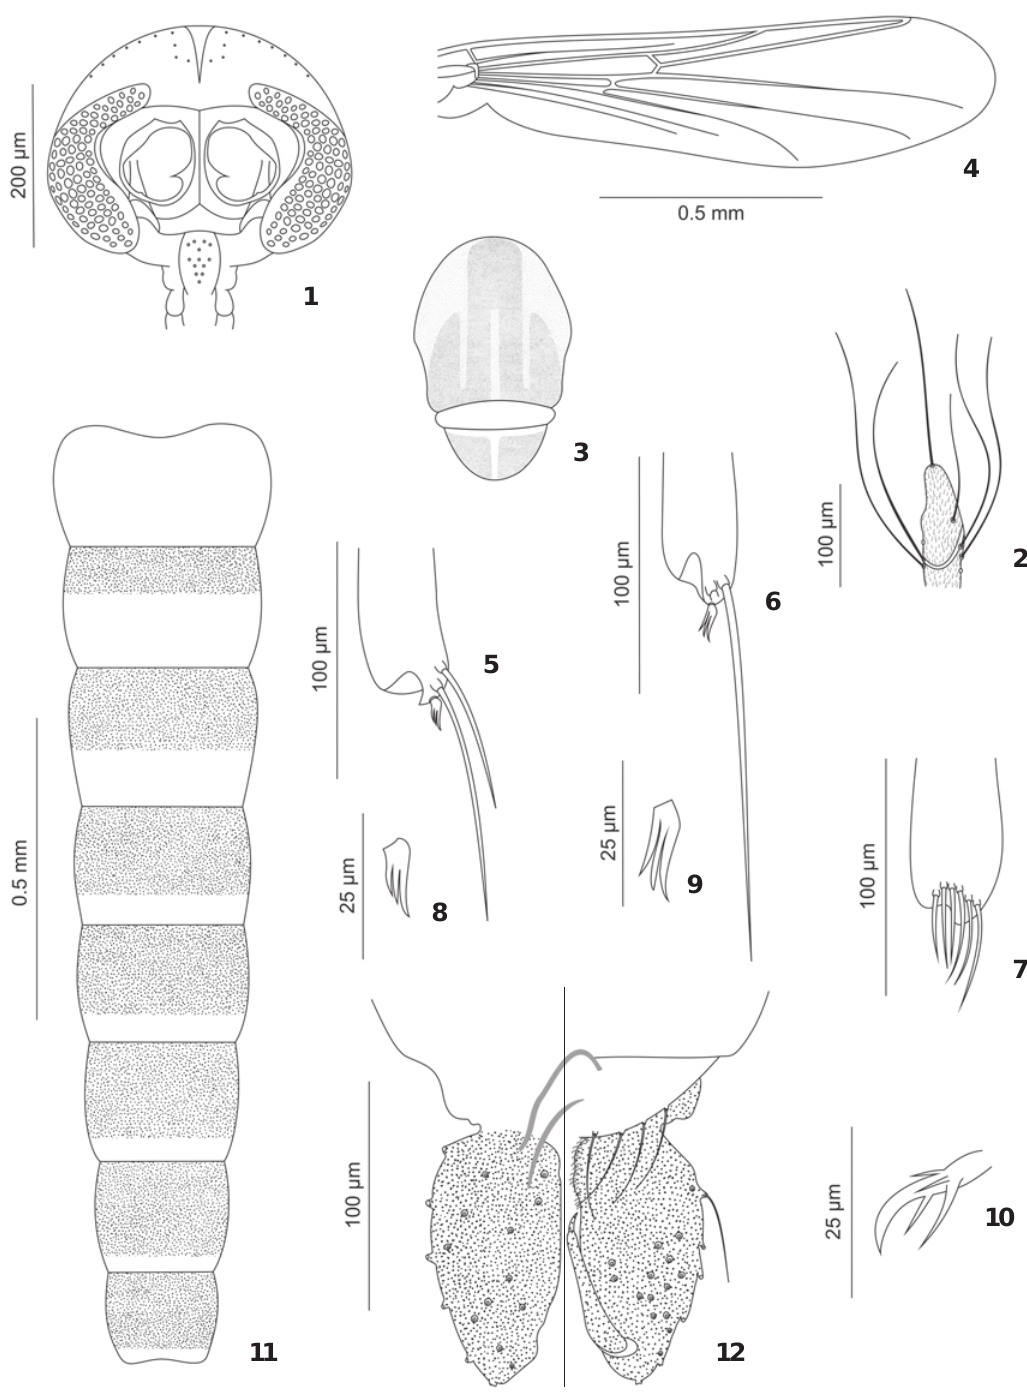
Figures 1-12. Labrundinia tenata , male: (1) head, dorsal view; (2) apex of Antenna. 3. thorax; (4) wing; (5) apex of fore tibia; (6) apex of mid tibia; (7) apex of hind tibia with comb; (8) fore spur; (9) mid spur; (10) hind tarsal claw; (11) abdomen coloration, dorsal aspect; (12) hypopygium, left: ventral aspect, right: dorsal